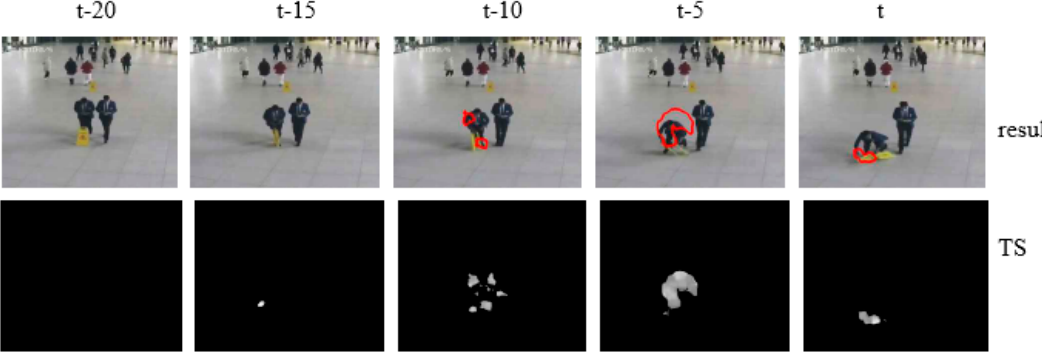
Figure 14. Examples of detection results for abnormality from the No. 7 data.